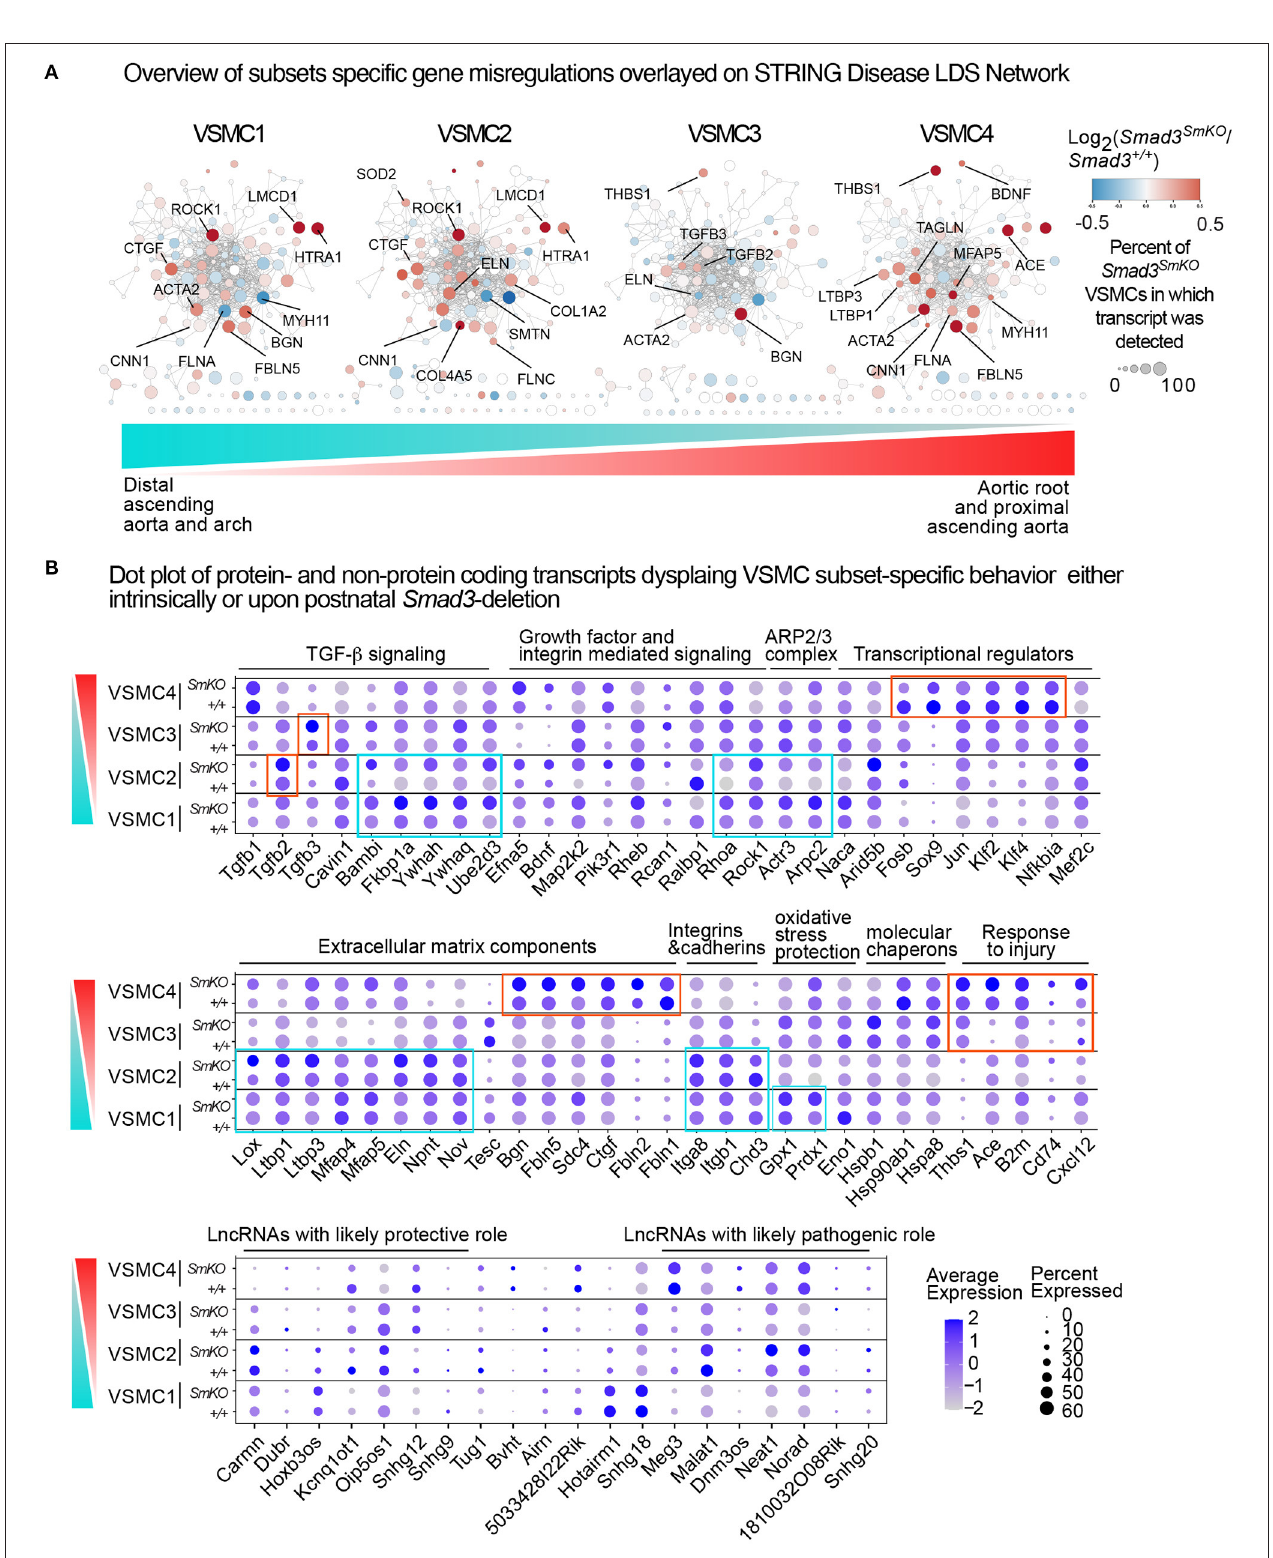
FIGURE 9 | Intrinsic and disease-associated transcriptional signatures in the VSMC subclusters. (A) Networks related to LDS1-5 were downloaded from the STRING Disease database, and overlayed with relative expression data for each VSMC subset using Cytoscape. Genes shown in blue are downregulated and genes shown in red are upregulated in Smad3 SmKO relative to controls. Scale indicates the average Log 2 FC in expression in Smad3 -deficient VSMCs relative to controls for transcripts